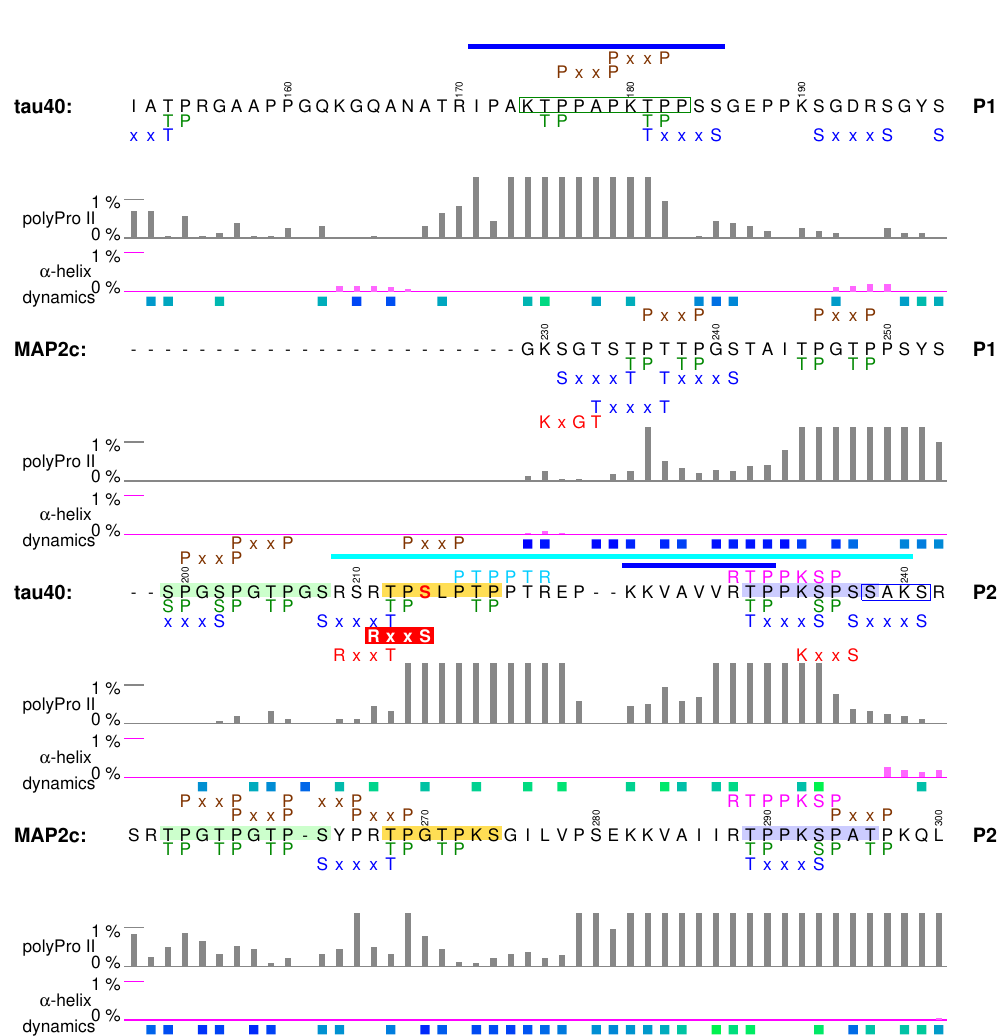
Figure 5. Sequences of proline-rich domains of human tau40 and rat MAP2c. Complex phosphorylation sites shown in the green frame and in pale green, pale blue, and red boxes are described in the text. The classical Class I and Class II SH3 binding sites are presented in magenta and cyan, respectively, above the sequence. Regions of tau interacting with tubulin are indicated by the blue bars above the sequence. Other symbols are used as described for Figures 3 and